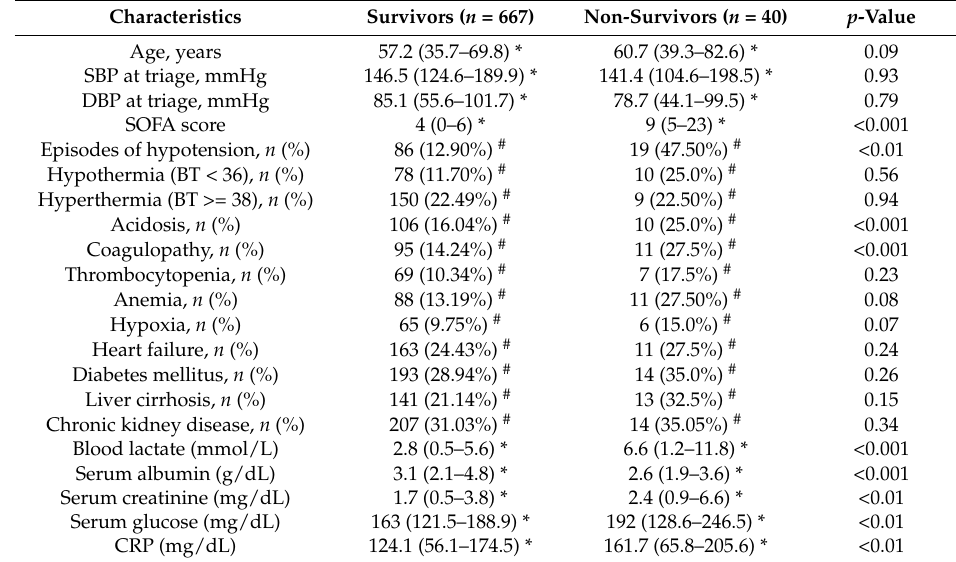
Table 1. Comparison of demographic and clinical characteristics and laboratory findings on